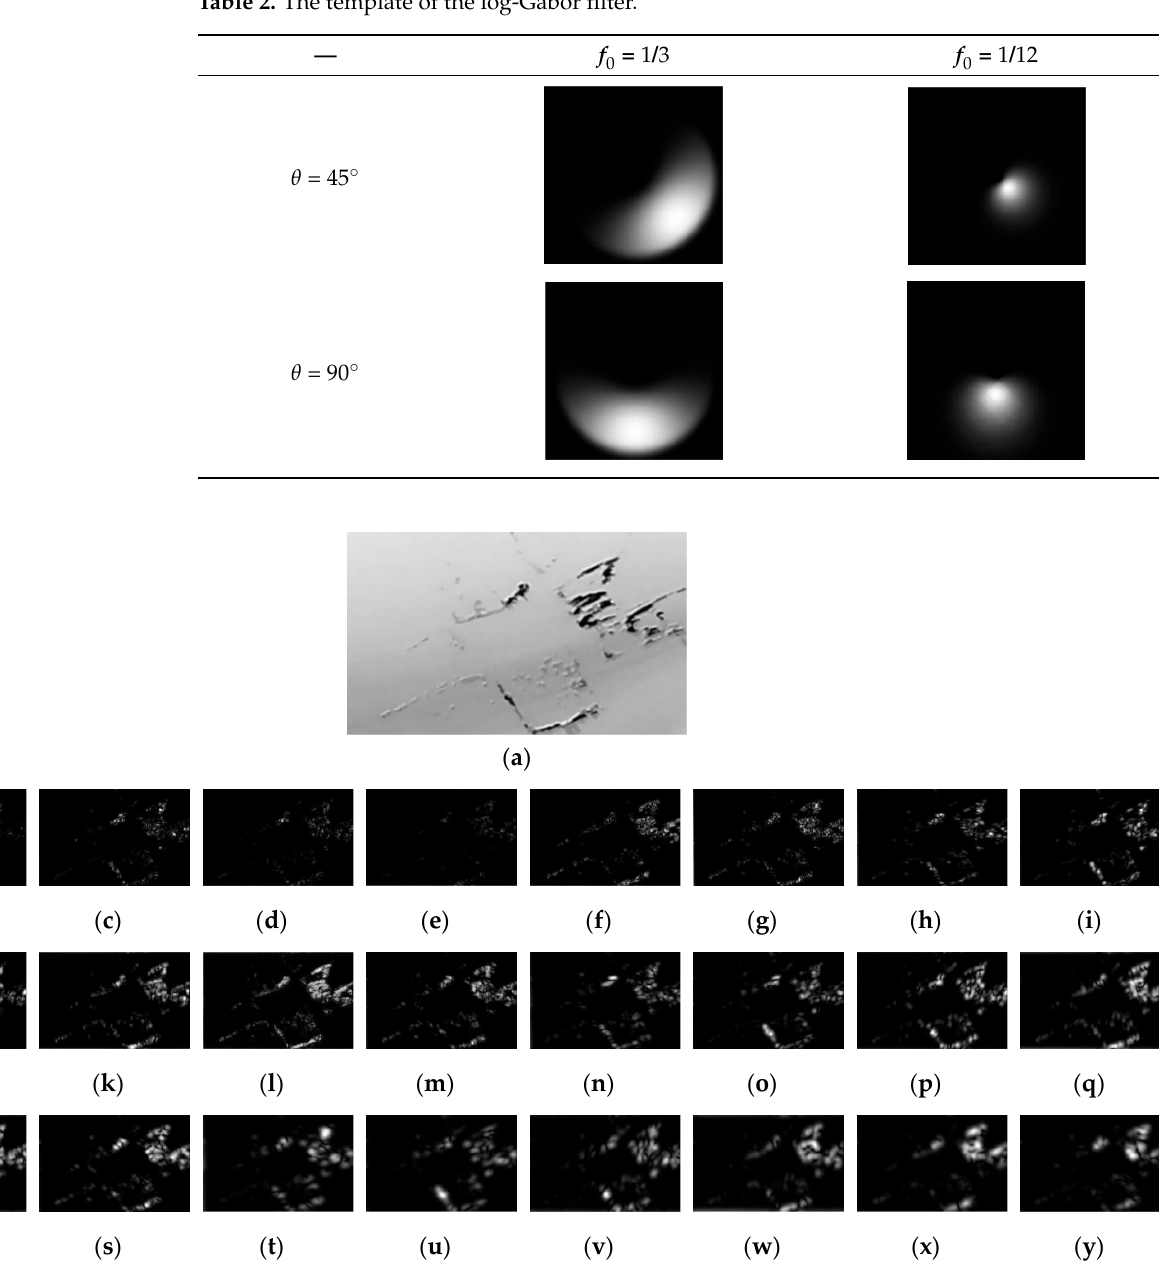
Figure 9. The images resulting from the log-Gabor filter: ( a ) is the original defect drawing; ( b – y ) are 24 feature extracted output images.